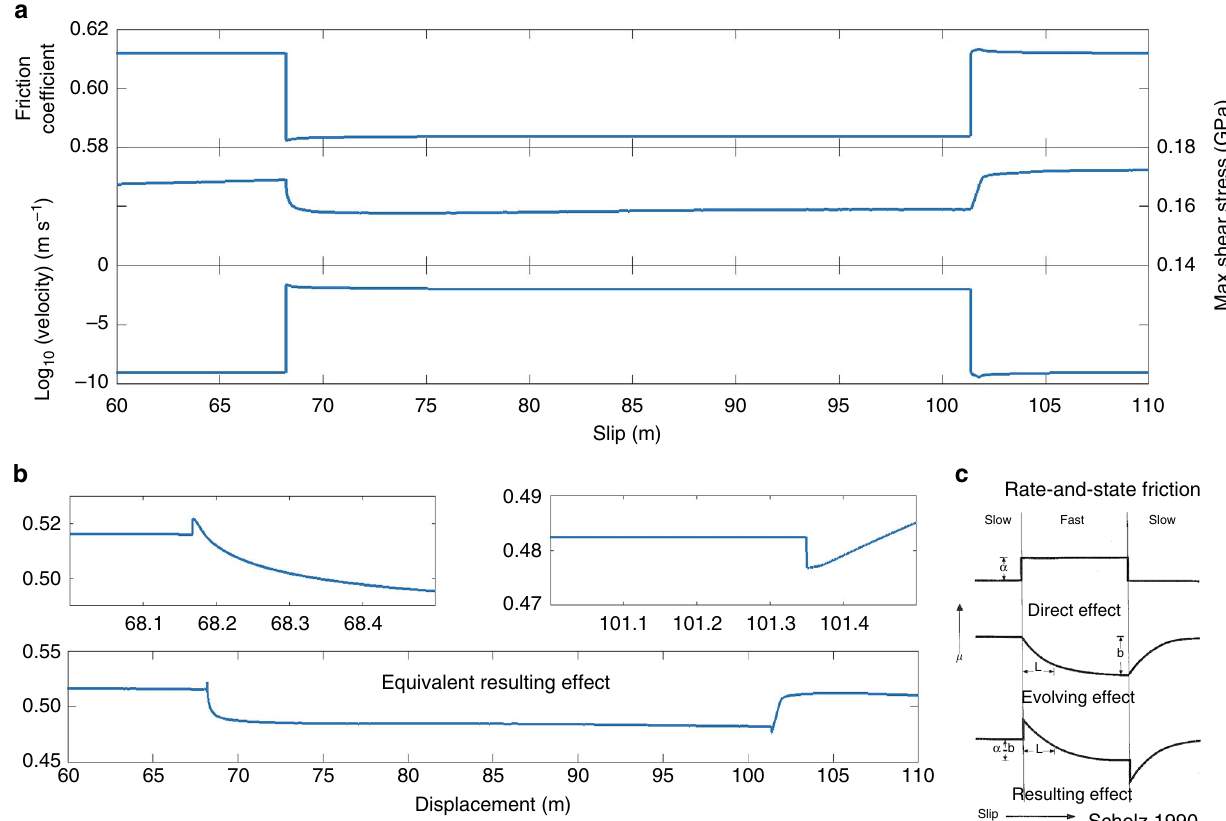
Fig. 2 Velocity stepping test. a Friction coef fi cient, maximum shear stress, and velocity against displacement. Rate-dependent friction shows the direct response to the velocity change. The maximum shear stress also changes but with delay. b Calculated equivalent resulting effects. The resulting effect has an instantaneous increase followed by a gradual decrease. c Direct, evolving, and resulting frictional effect of the rate-and-state-dependent friction